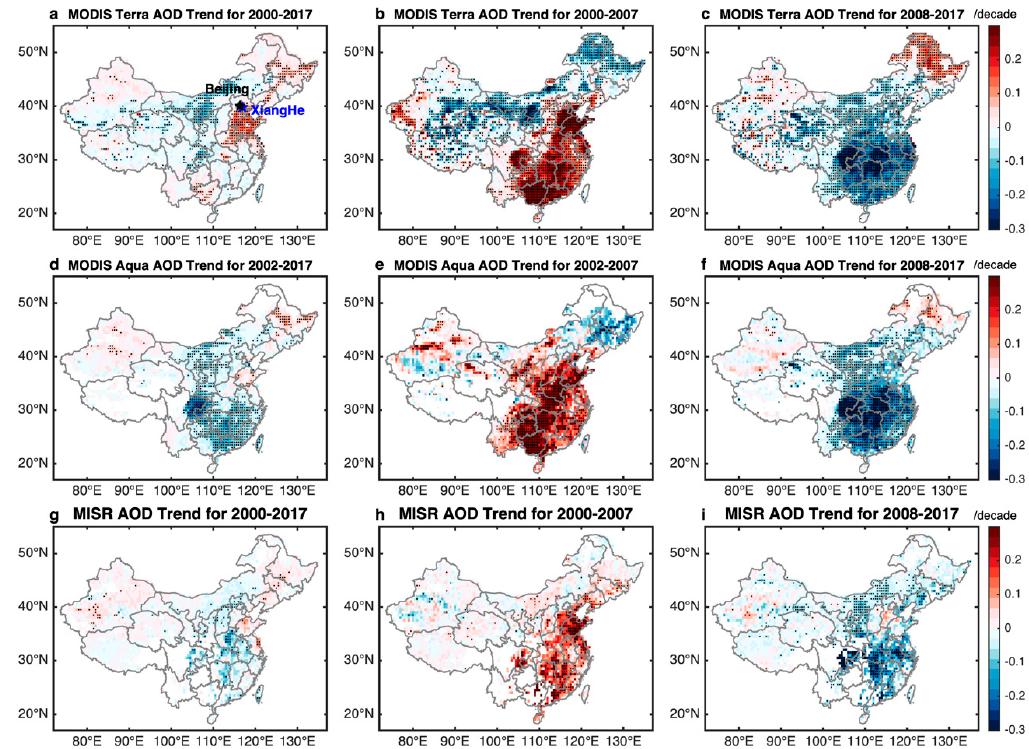
Figure 2. MODIS Terra ( a – c ), MODIS Aqua ( d – f ) and MISR ( g – i ) AOD trends over China for the 2000–2017 ( a , d , g , 2002–2017 for MODIS Aqua), 2000–2007 ( b , e , h , 2002–2017 for MODIS Aqua) and 2008– 2017 ( c , f , i ) periods. The trends were calculated as the Sen’s slope and tested using the Mann–Kendall